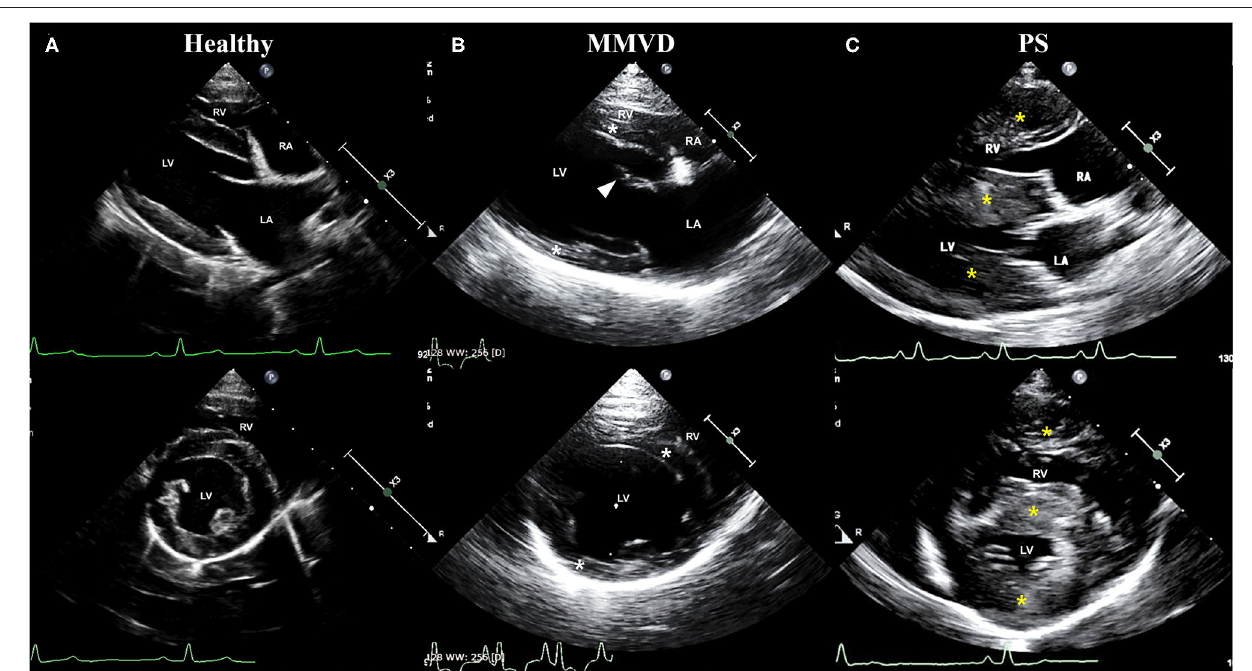
FIGURE 1 | Representative echocardiographic images of dogs included in (A) healthy, (B) MMVD, and (C) PS groups. Upper images are right parasternal 4-chamber view, and lower images are right parasternal short-axis view. All images were taken during the diastole. (B) Note the enlargement of chambers (LV and LA), eccentric hypertrophy of ventricular walls (white asterisk), and thickened mitral valve (arrowhead) in a dog with MMVD. (C) Also, note the concentric hypertrophy of ventricular walls (yellow asterisk) in a dog with PS. LA, left atrium; LV, left ventricle; MMVD, myxomatous mitral valve degeneration; PS, pulmonic stenosis; RA, right atrium; RV, right